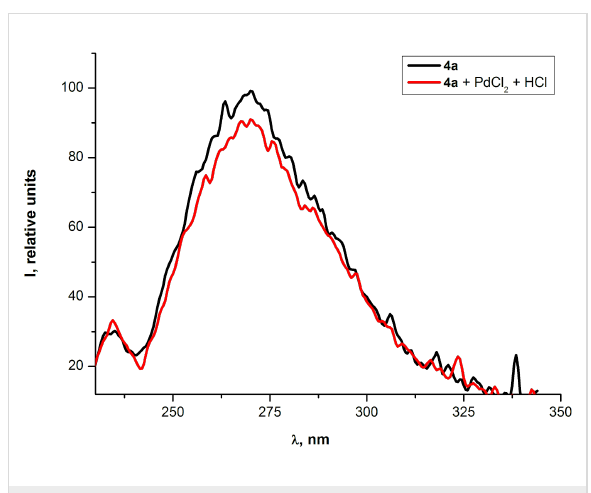
Figure 17: Emission spectra of cinnoline 4a in THF before and after the addition of aqueous solution of PdCl 2